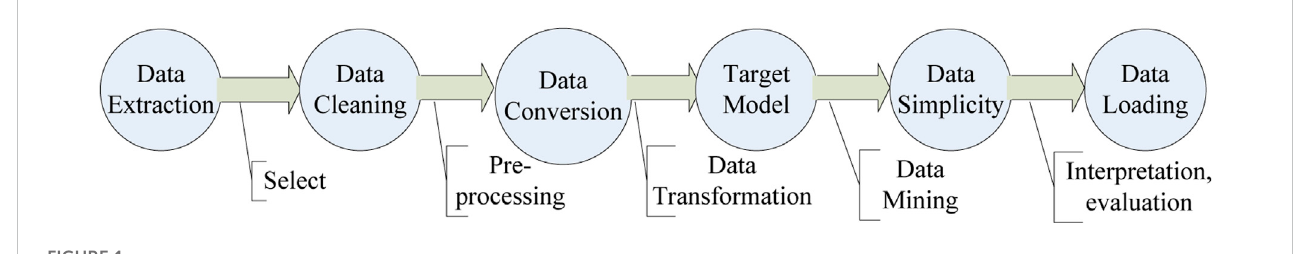
FIGURE 1 The general process of data mining.